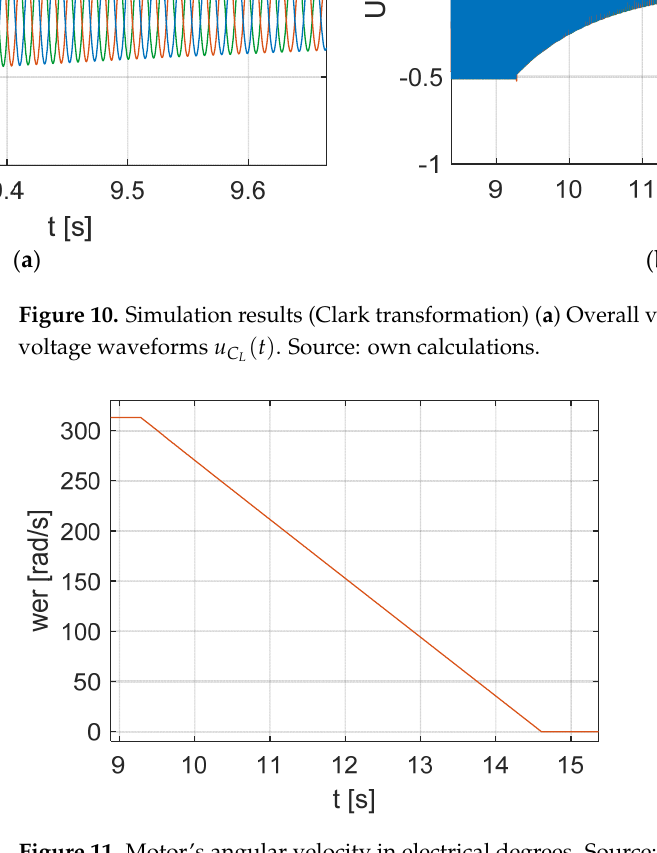
Figure 11. Motor’s angular velocity in electrical degrees. Source: own